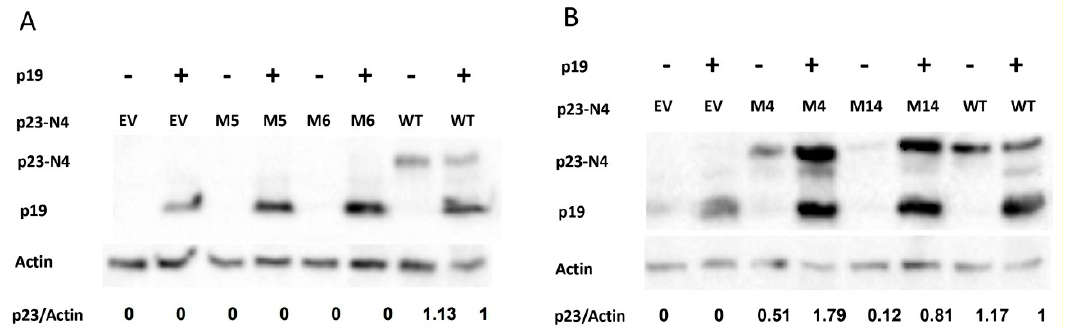
Figure 6. Point mutation in M5 and M6 but not M4 and M14 abolish p23 protein stability. p19 was co-infiltrated with N4p23 WT, M, or EV. Each row, top to bottom: p23 protein, p19 protein, and Actin protein and gray value ratio of p23 protein/Actin protein.